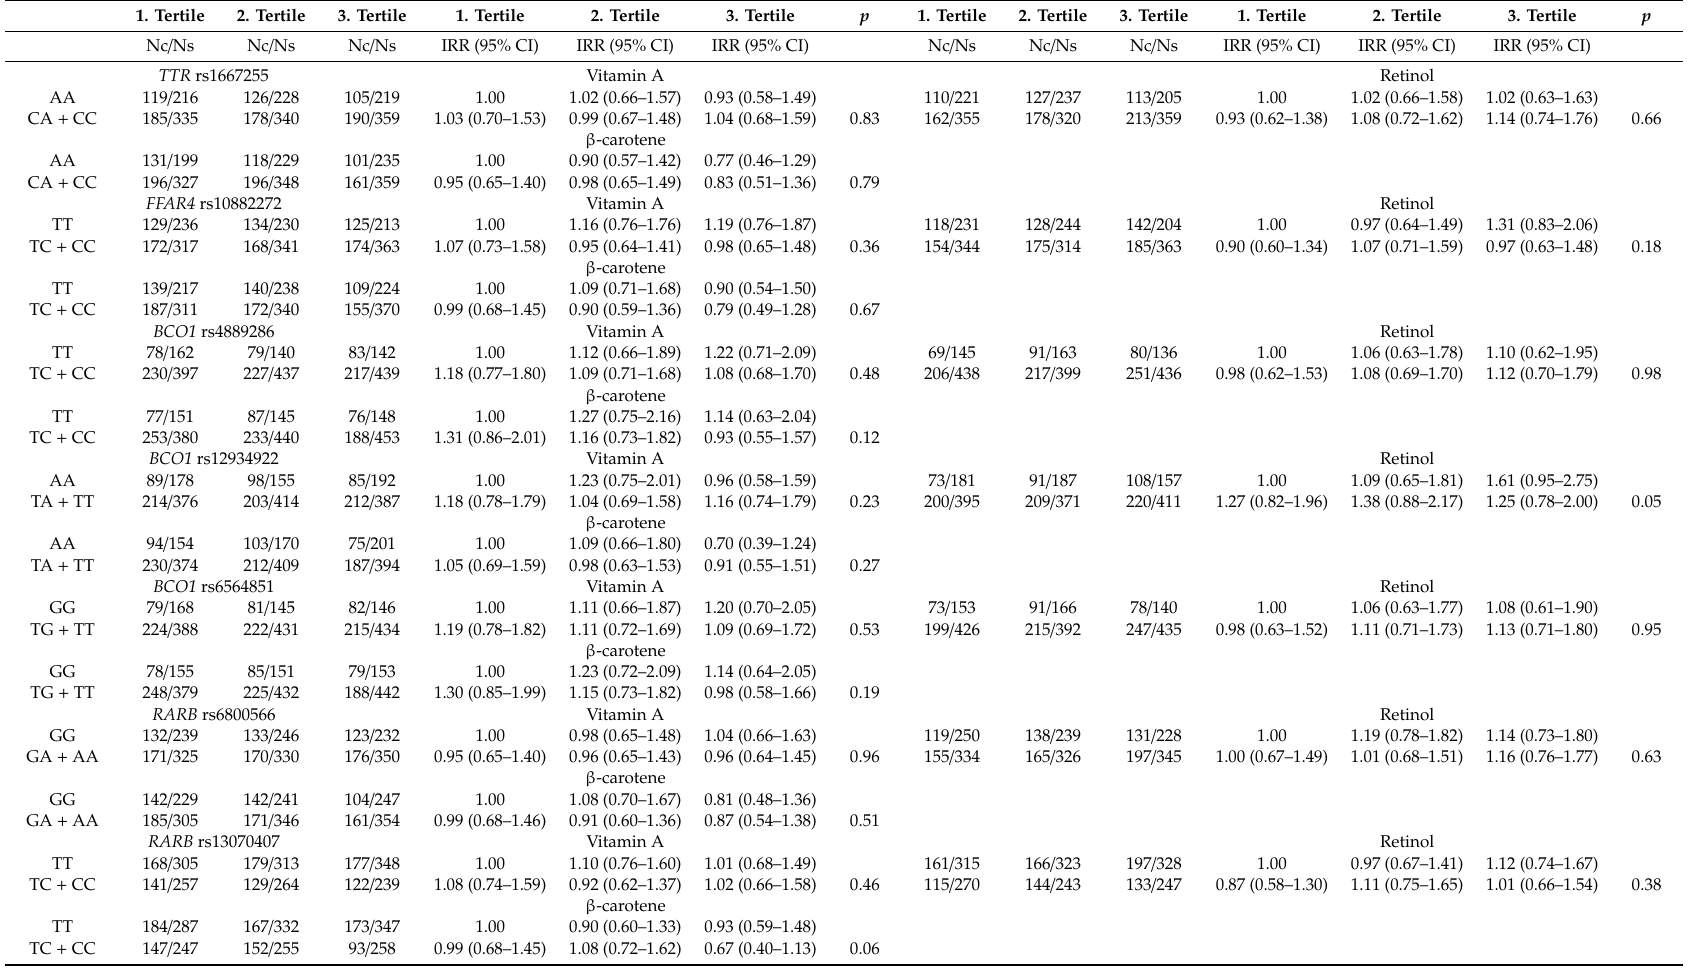
Table 5. Tertile analyses of polymorphisms and dietary intake of vitamin A, β -carotene, and